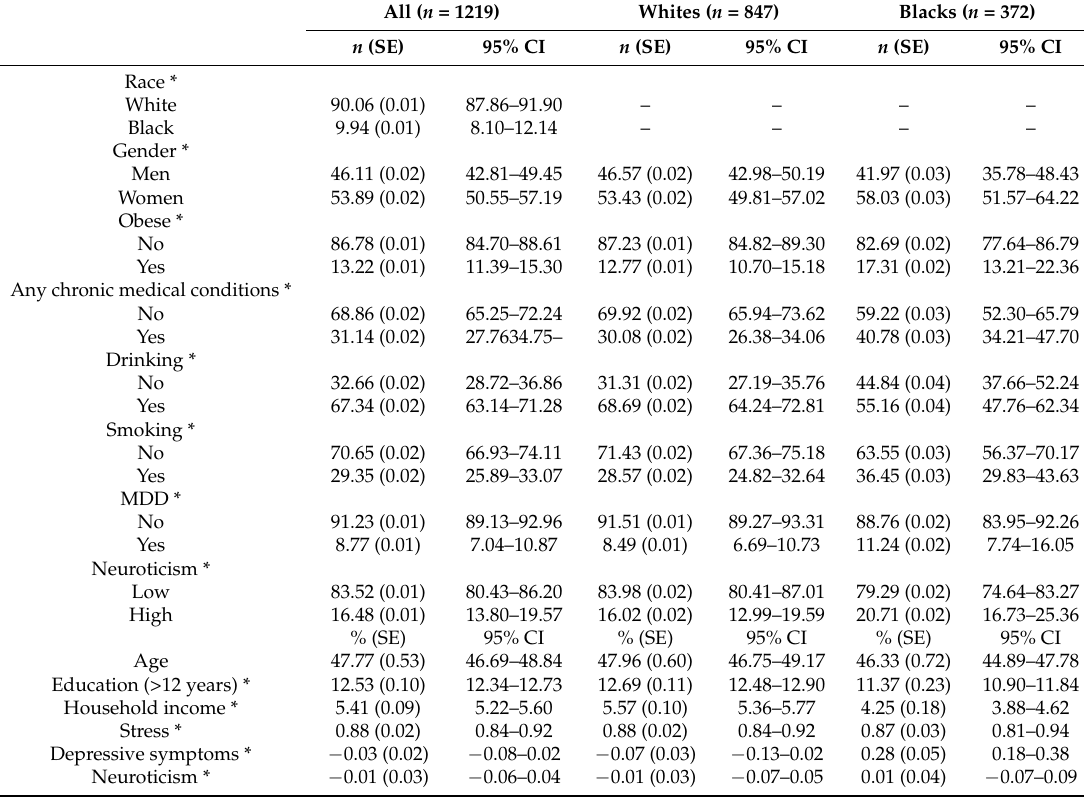
Table 1. Descriptive statistics for baseline characteristics based on